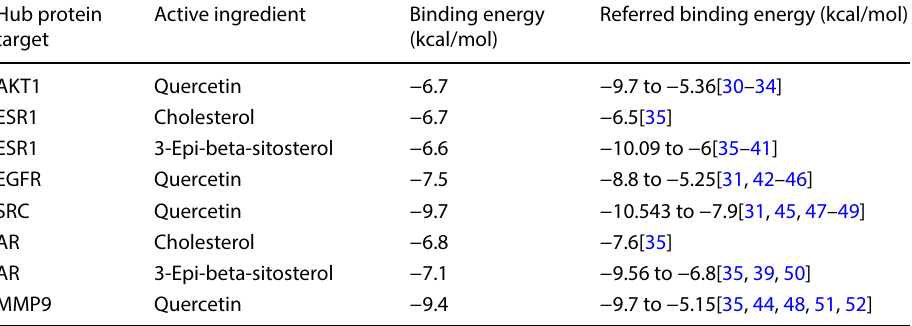
Table 3 Binding energy of S. nigrum active ingredients to the key protein